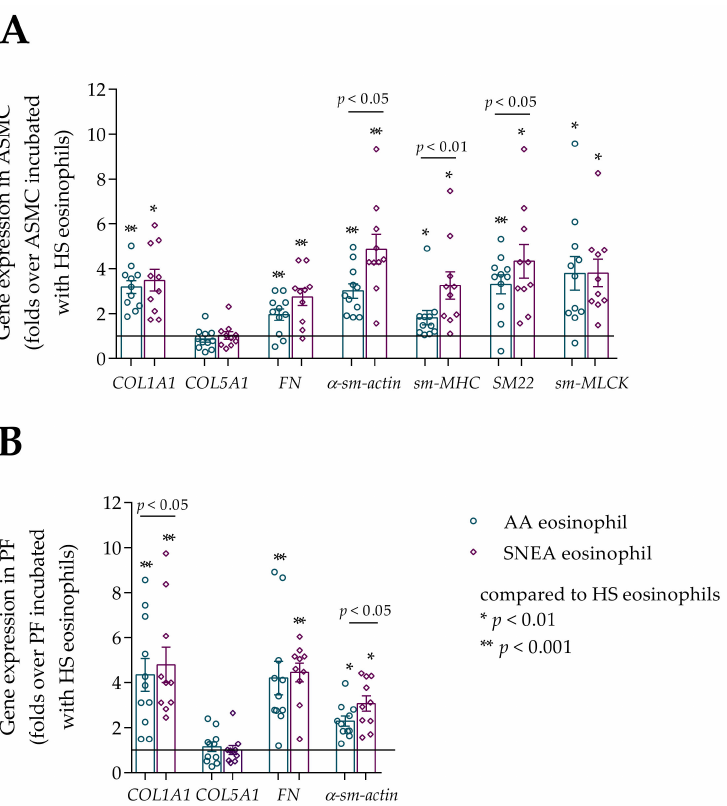
Figure 7. ( A )–Gene expression in ASMC after incubation with eosinophils; ( B )–Gene expression in PF after incubation with eosinophils. Data presented as folds over the HS eosinophil effect as mean ± SEM. AA—allergic asthma patient; SNEA—severe non-allergic eosinophilic asthma patient; ASMC—airway smooth muscle cells; PF–pulmonary fibroblast; HS—healthy subject; COL1A1 — collagen I α 1; COL5A1 —collagen V α 1; FN —fibronectin; α -sm-actin— α smooth muscle actin; sm - MHC —smooth muscle myosin heavy chain; SM22 —transgelin; sm-MLCK —smooth muscle myosin light chain kinase. * p < 0.01 compared to HS eosinophils; ** p < 0.001 compared to HS eosinophils. AA n = 11; SNEA n = 10; HS n = 8. Statistical analysis between investigated groups—Mann–Whitney two- sided U-test (independent data); Wilcoxon signed-rank test was used for gene expression analysis against ASMC or PF control. Lines connect comparison groups with a p -value denoting the significant difference in pair-wise